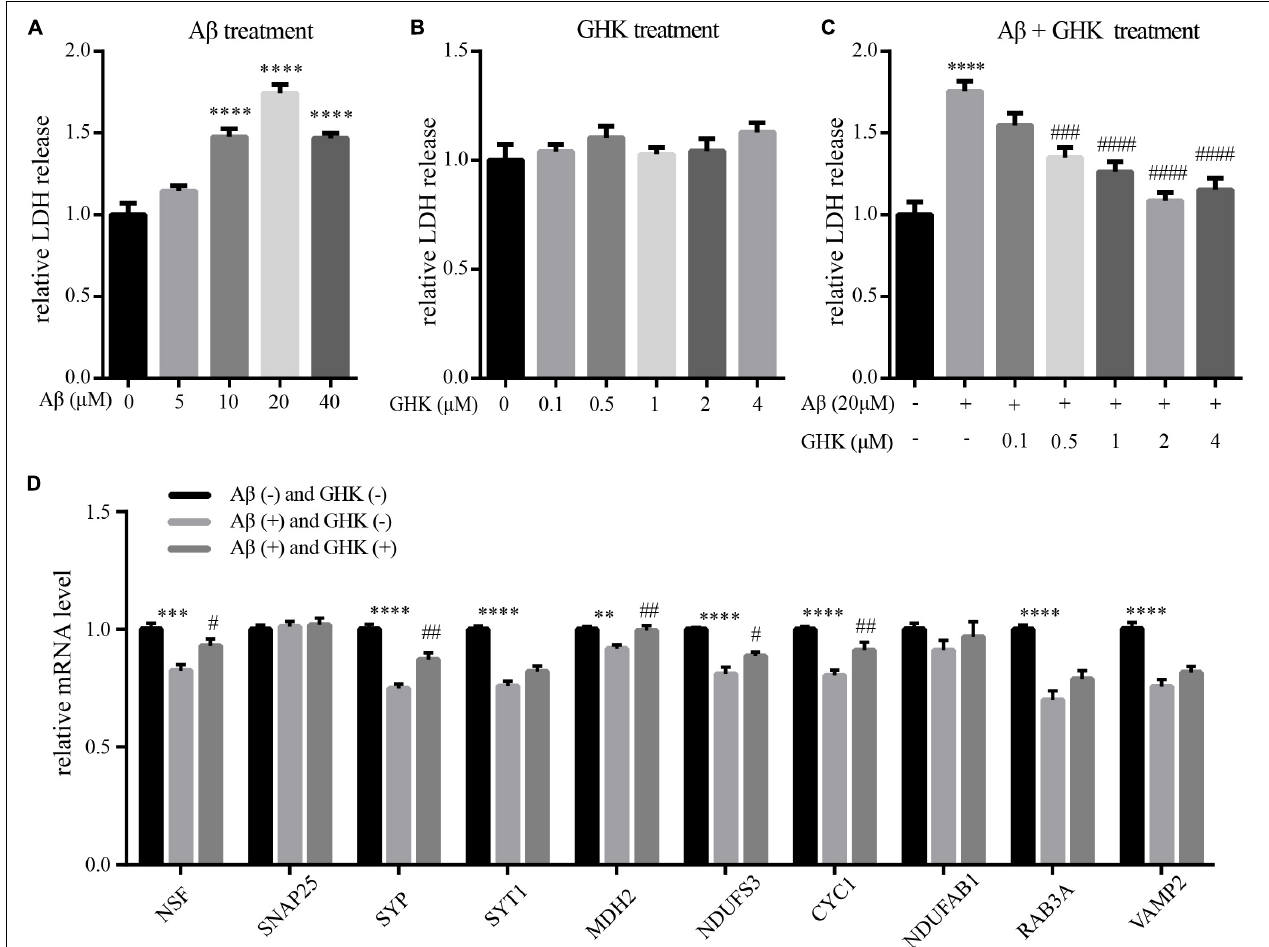
FIGURE 6 | The neuroprotective effect of tripeptide GHK against A β 25 − 35 -induced cytotoxicity in differentiated human SH-SY5Y cells. (A–C) Statistical data showing LDH release from cells treated with (A) different concentrations of A β 25 − 35 for 24 h, (B) different concentration of GHK for 24 h, (C) different concentrations of GHK for 6 h before addition of A β 25 − 35 (20 µ M) for another 24 h. (D) mRNA expression level of 10 hub genes in cells of control group, A β 25 − 35 group, A β 25 − 35 + GHK group. Values represent mean ± SEM (n = 9) and are normalized to the control group (black column). ANOVA with Dunnet’s post-hoc test was used to determine statistical significance. ∗∗ p < 0.01, ∗∗∗ p < 0.001, ∗∗∗∗ p < 0.0001, compared to control group, # p < 0.05, ## p < 0.01, ### p < 0.001, #### p < 0.0001, compared to A β 25 − 35 treatment